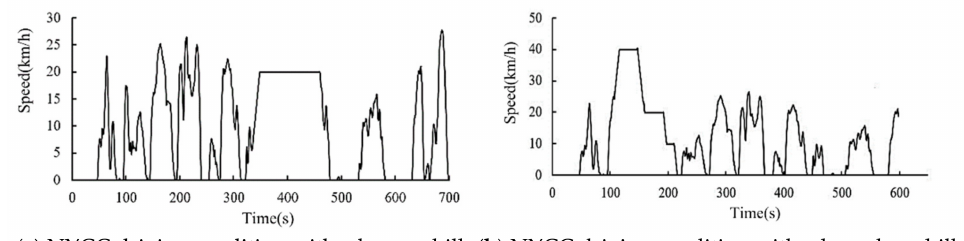
Figure 6. Incorporation of up and down slopes into NYCC driving